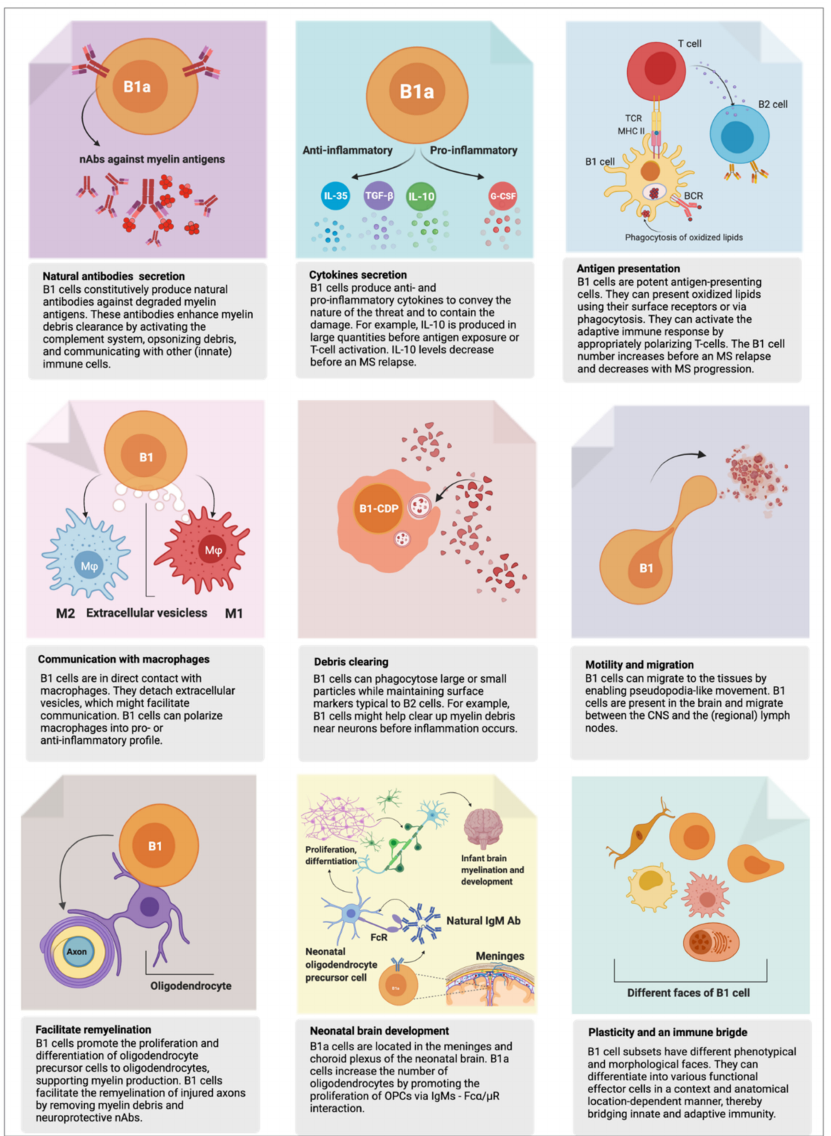
Figure 2. An overview of B1 cell functions. The B1 cell fulfills crucial homeostatic functions. However, it can act as a “double-edged sword,” playing a protective or harmful role. Here, we present an